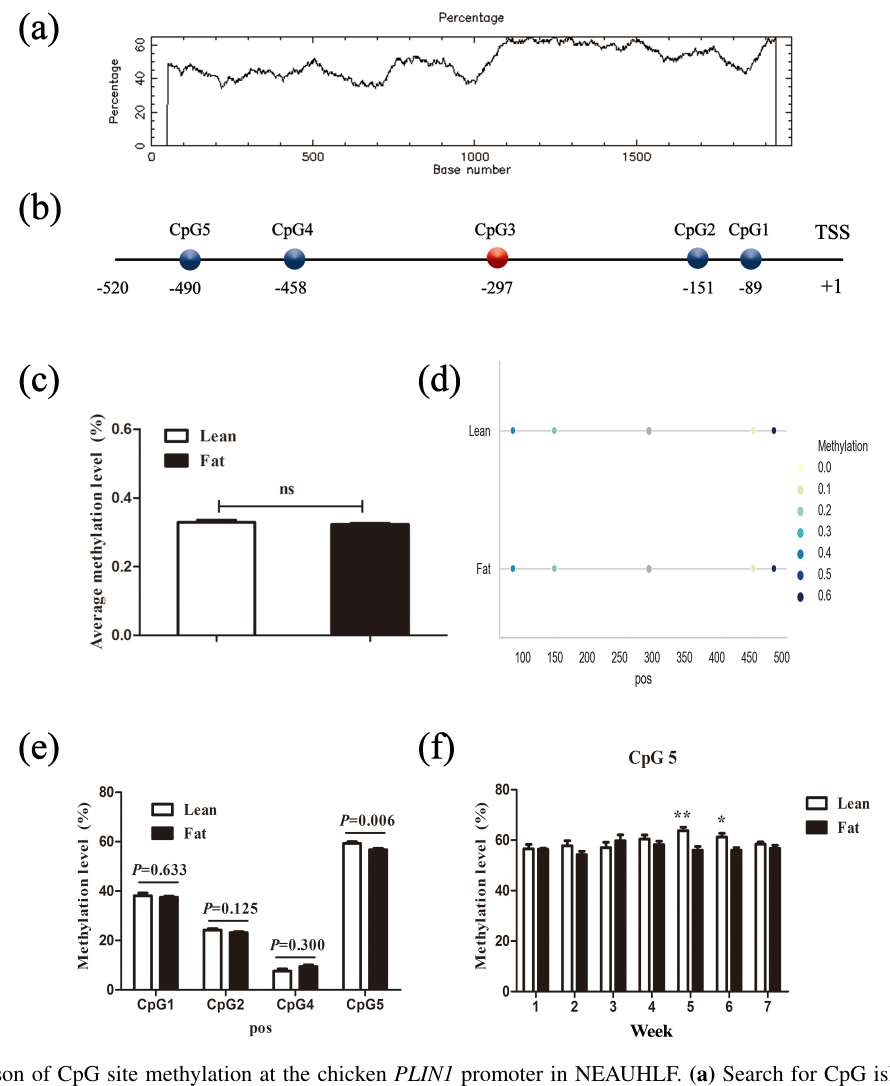
Mean AFW and AFP of each week ( n = 5)